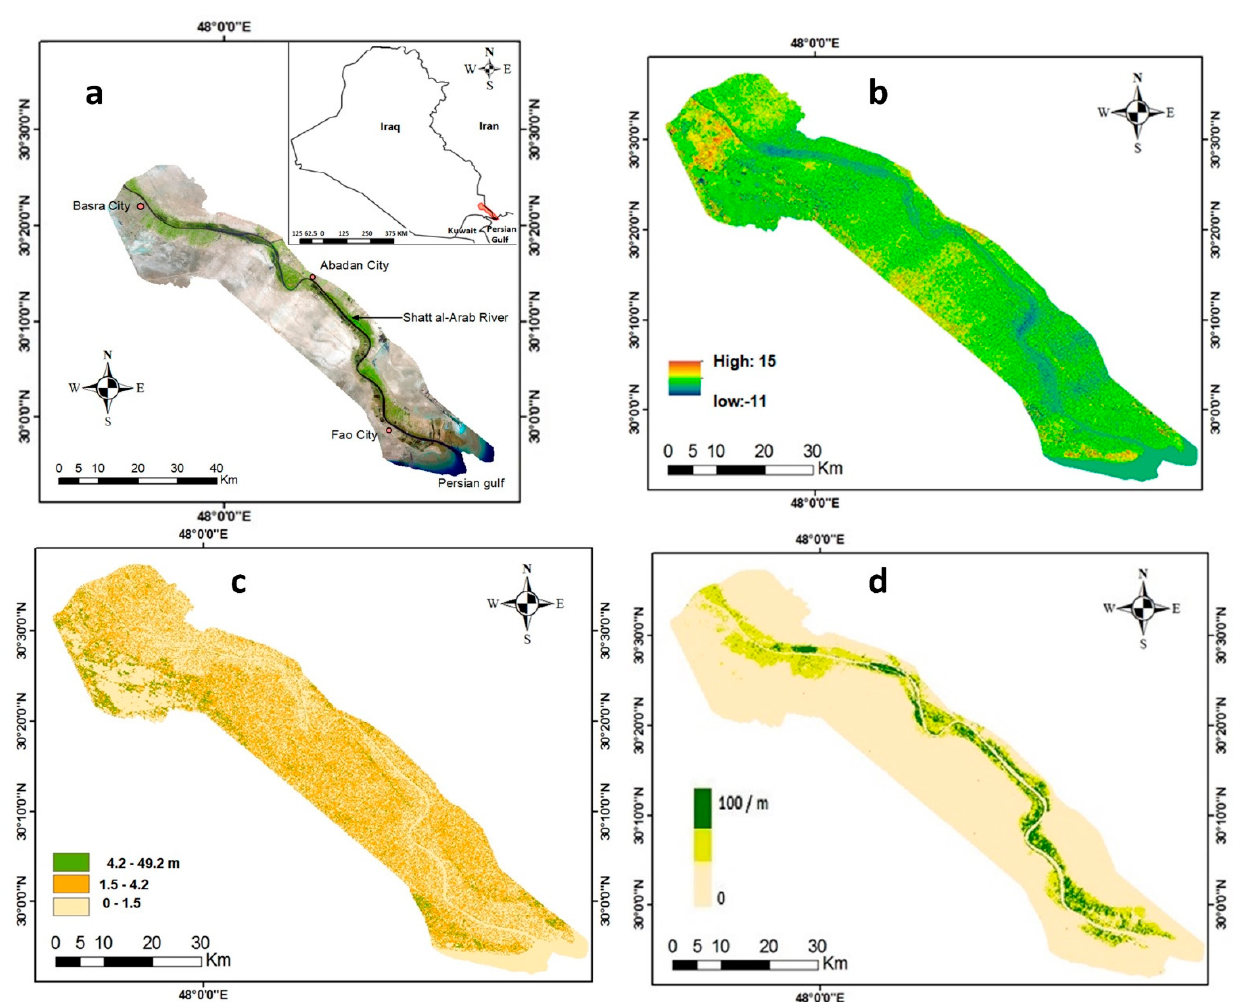
Figure 1. ( a ) Landsat imagery for the Shatt Al-Arab River study region in Iraq (From: USGS: https://earthexplorer.usgs.gov/ accessed on 13 May 2021); ( b ) SRTM 1 arc second (30 m) global coverage (From: NASA Shuttle Radar Topography Mission (SRTM) Version 3.0 Global 1 arc second); ( c ) SRTM-derived slope (From: USGS: https://pubs.usgs.gov/pdf/ accessed on 13 May 2021); ( d ) vegetation cover fraction (VCF) (derived from Landsat 5 TM Collection 1).